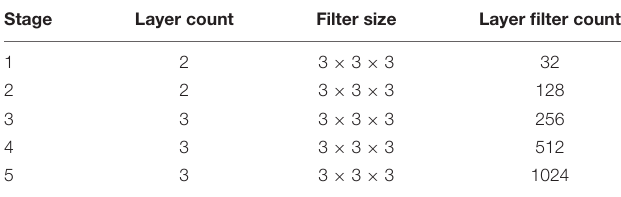
TABLE 1 | CNN architectural